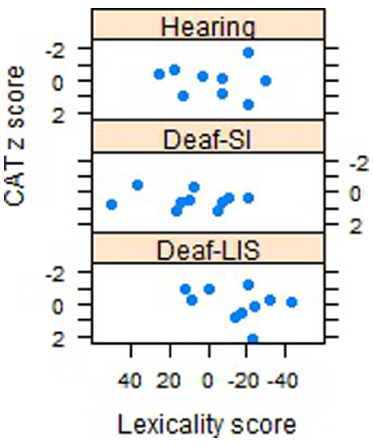
Figure 2. Lexicality effect and phonological fluency task. Scatterplot depicting the mean number of correct responses for each participant within groups (FAS z score), plotted against reaction time difference score between words and consonant strings (Lexicality score).